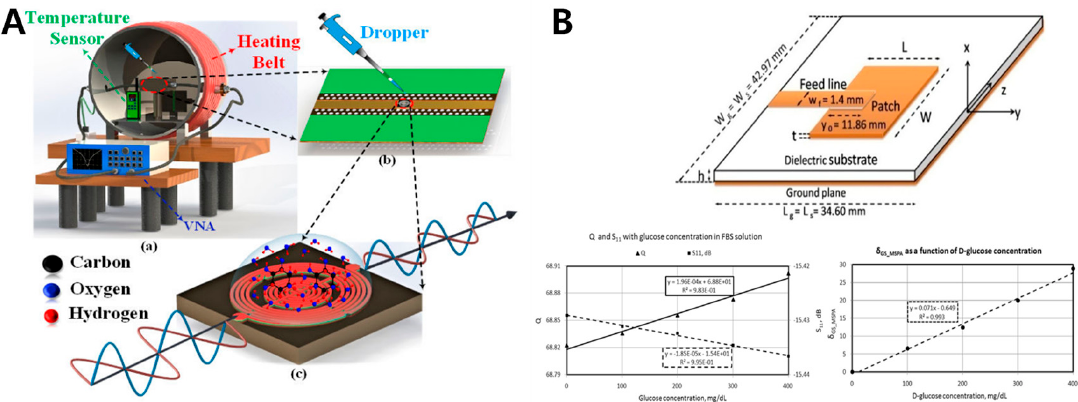
Figure 7. Microwave methods. ( A ) High-sensitivity, quantified, linear and mediator-free resonator- based microwave biosensor for glucose detection. (a) Microwave-based glucose biosensor, (b) micro-